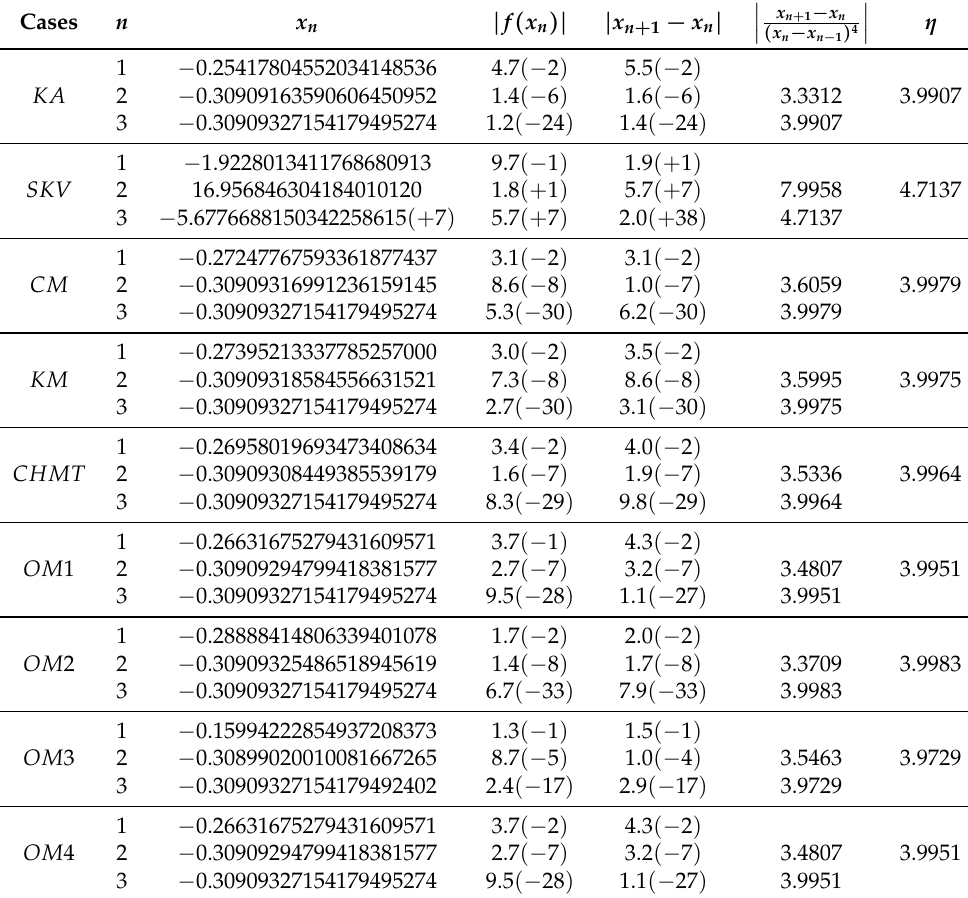
Table 5. Convergence behavior of different fourth-order optimal methods for f 3 ( x )